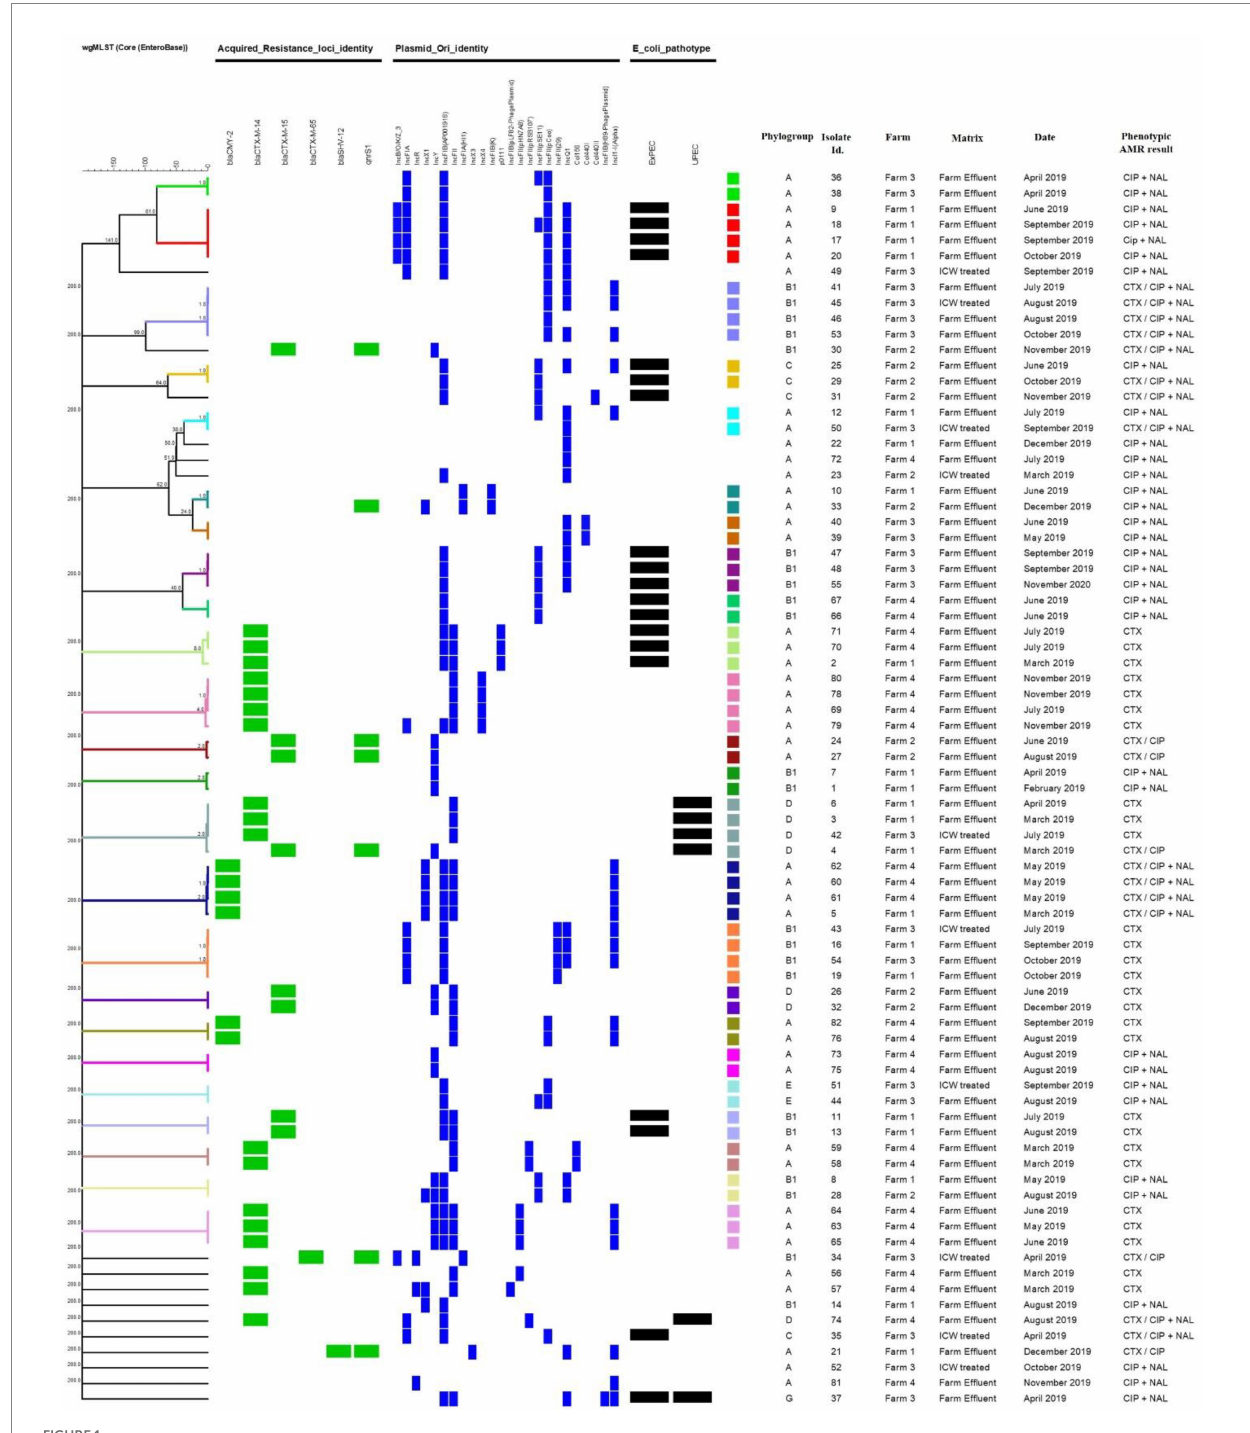
FIGURE 1 Dendrogram generated through cgMLST analysis with a scaling bar representing a phylogenic difference of 1 allele. The different color codes represent different clusters of highly related isolates ( ≤ 8 alleles). Also shown are the main acquired resistance genes, plasmids, pathoptyes and phylogroups identified. CTX, Cefotaxime; CIP, Ciprofloxacin; NAL, Nalidixic